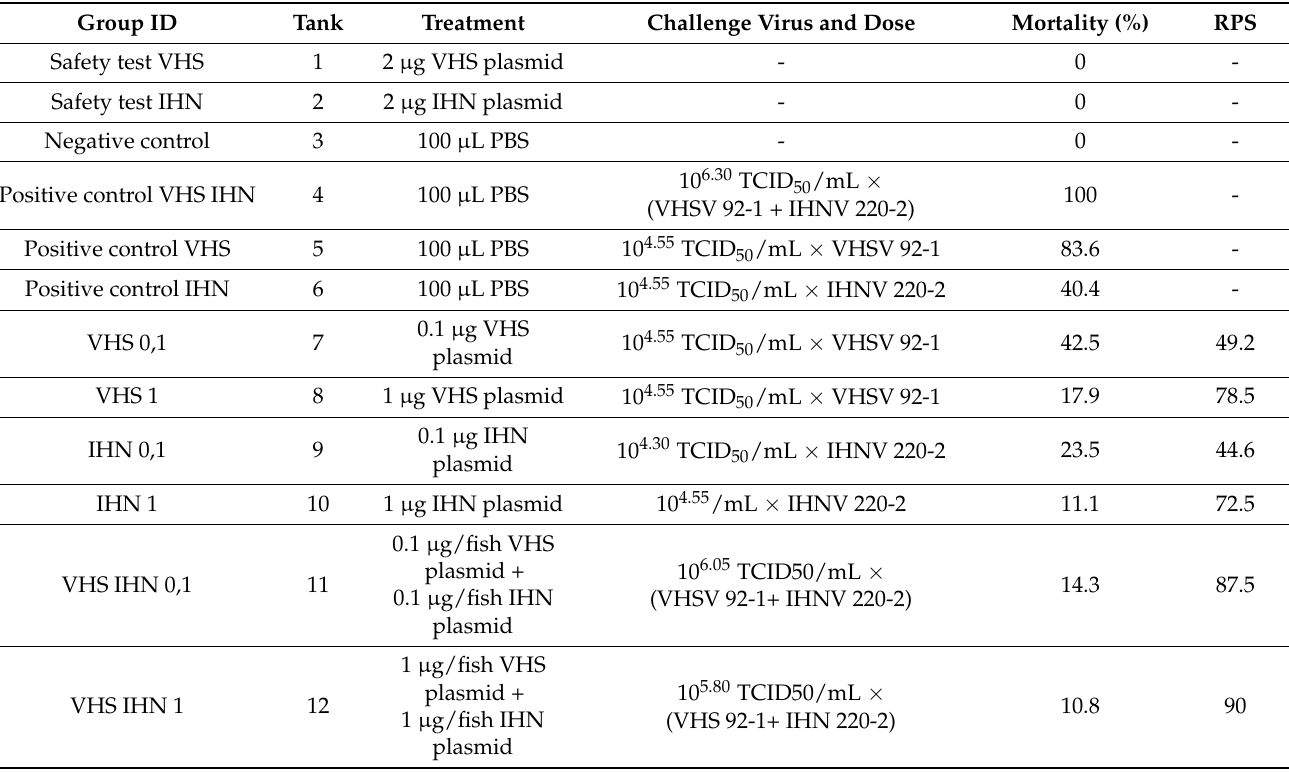
Table 4. Controlled conditions trial: summary of the challenge dose, cumulative mortality, and relative percent survival (RPS) per experimental group. RPS = relative percent survival.